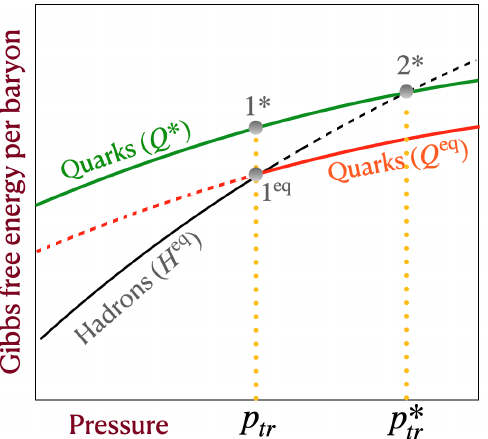
Figure 6. Gibbs free energy per baryon as a function of pressure for catalyzed hadronic matter (curve H eq ), catalyzed quark matter (curve Q eq ), and quark matter in the ’transition states’ (curve Q ∗